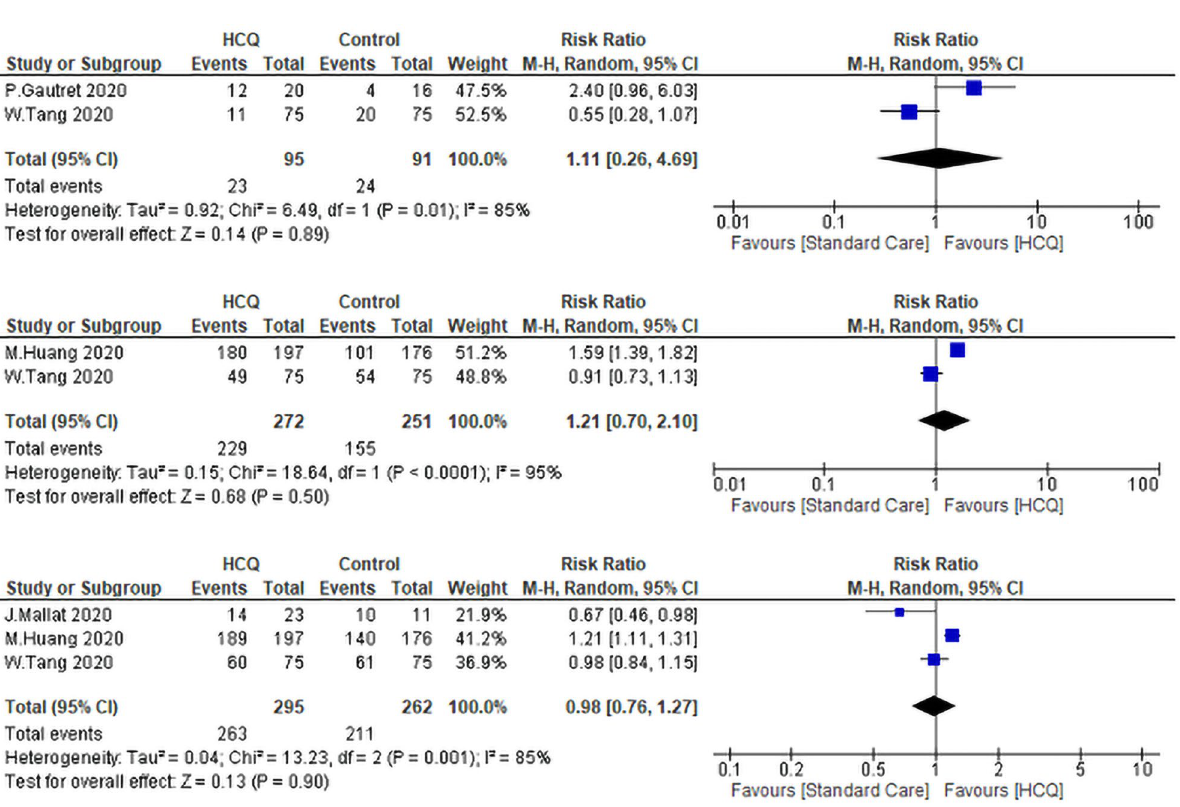
Figure 5. Duration of hospital stay of Hydroxychloroquine ± Azithromycin versus standard care.